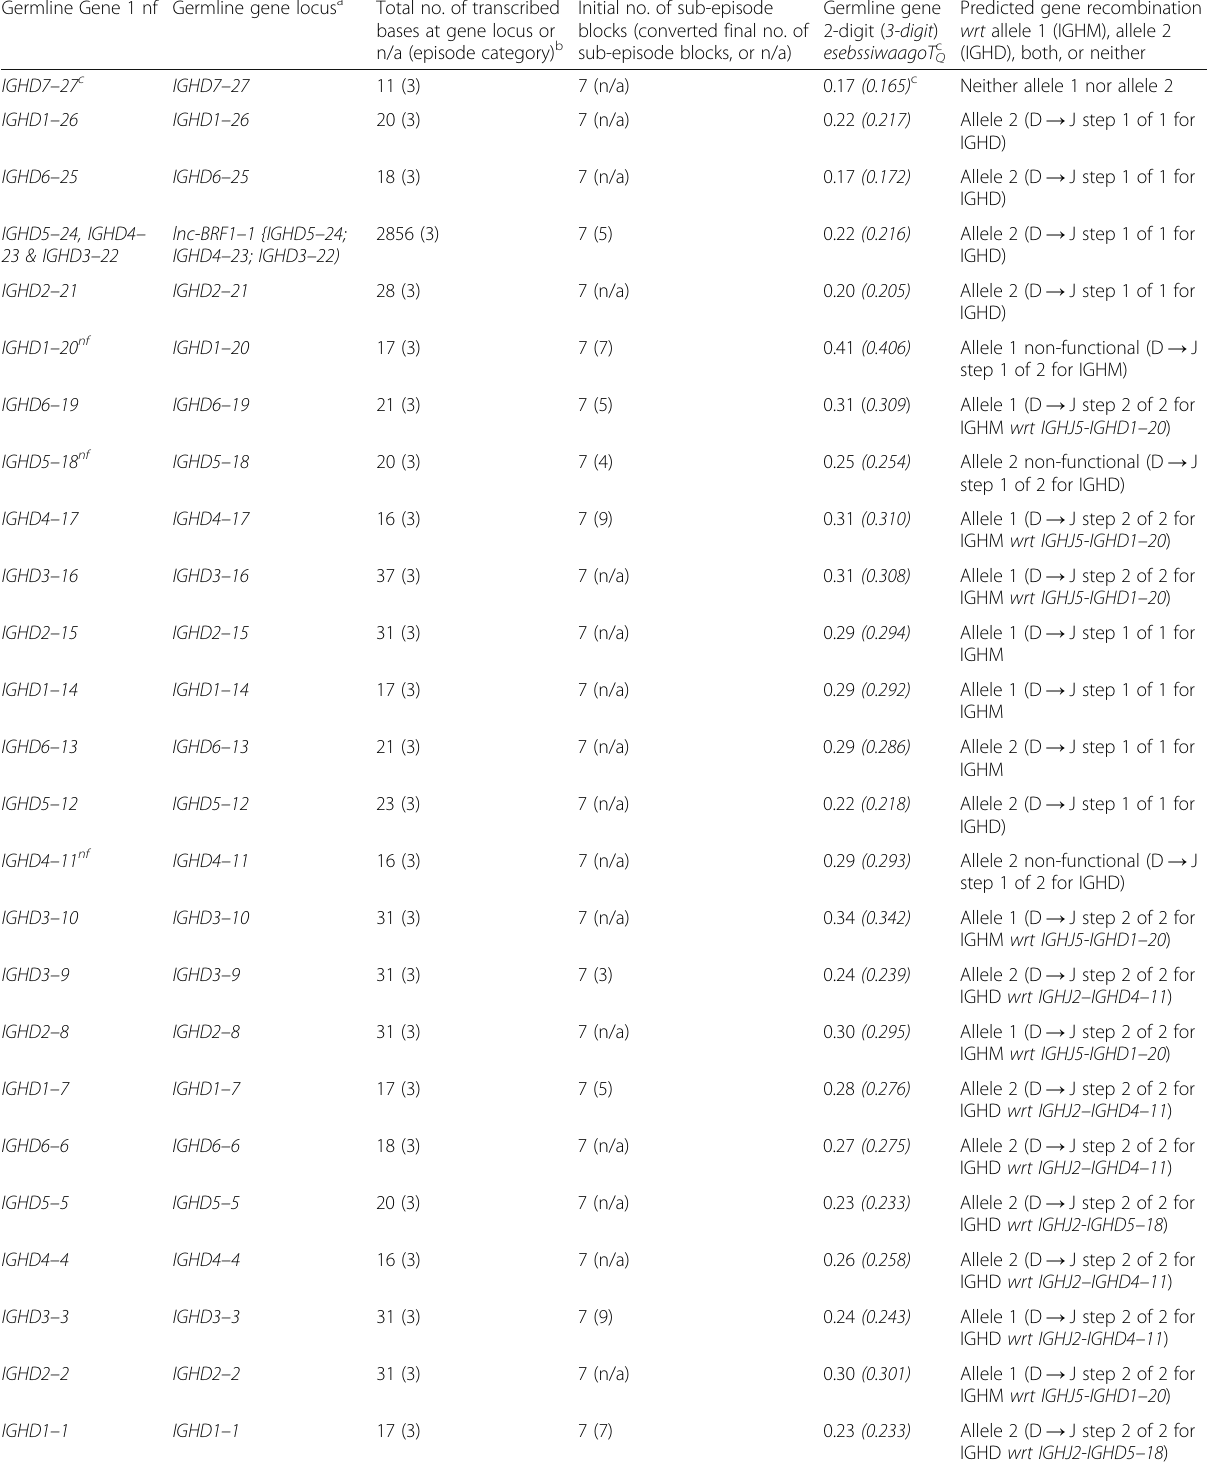
a only Ig genes and gene loci included, non-coding RNA genes (processed pseudogenes) excluded b > 11,864 ≤ 265,005 total transcribed bases, Episode category 2 gene; Episode category 3 gene bases, ≤ 11,864 total transcribed bases, Episode category 3 gene. c nadir esebssiwaagoT Q